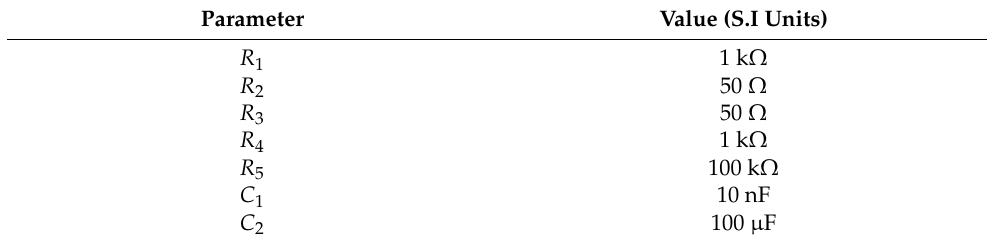
Table 3. List of parameters of Figure